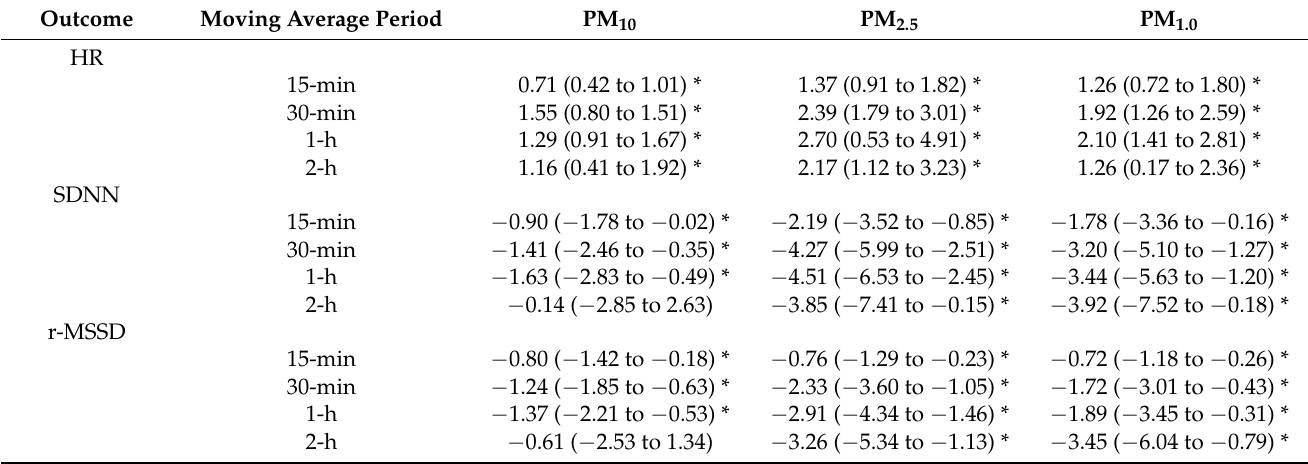
Table 2. Estimated percentage change (95% CIs) in HR and time-domain HRV indices by an interquartile range (IQR) † increase in PM exposure ( n = 54) ‡